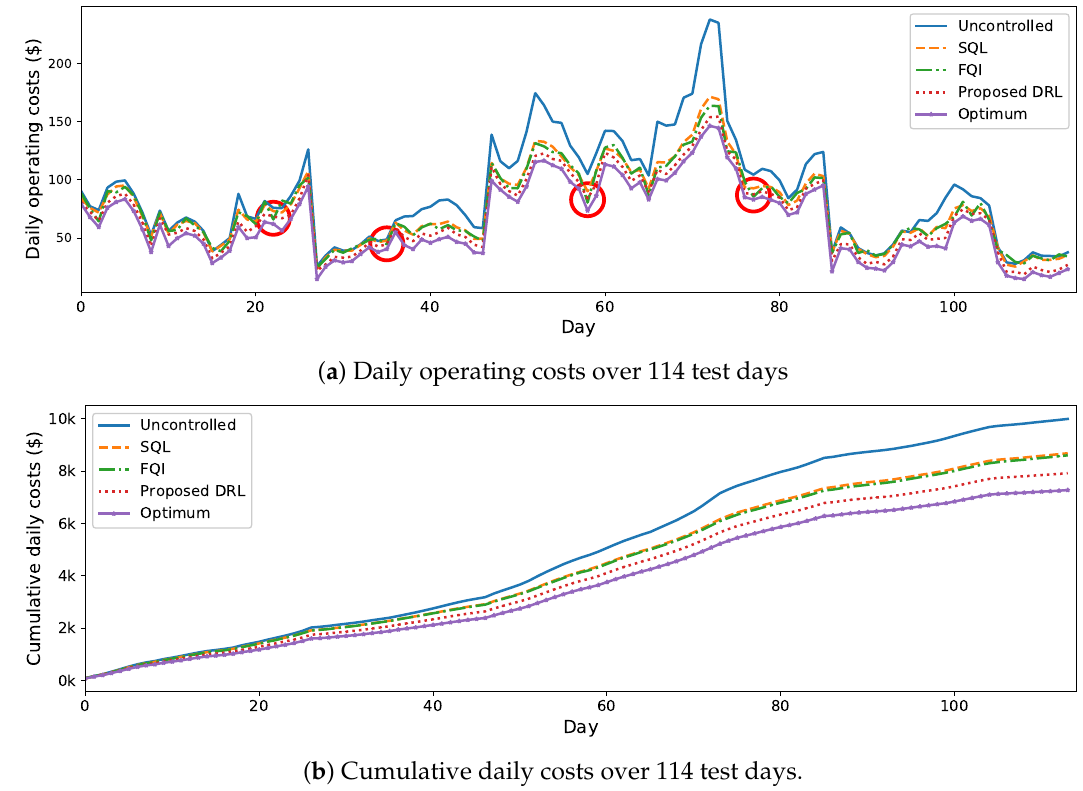
Figure 8. Daily operating costs and the corresponding cumulative daily costs over 114 test days obtained by the proposed approach and the benchmark